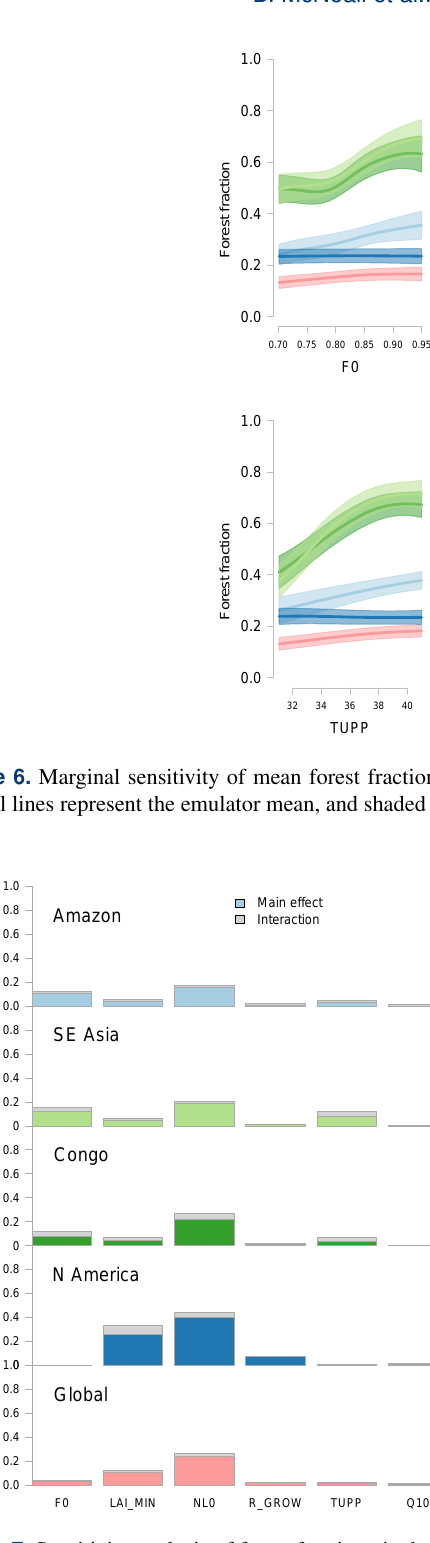
Figure 7. Sensitivity analysis of forest fraction via the FAST algo- rithm of Saltelli et al.